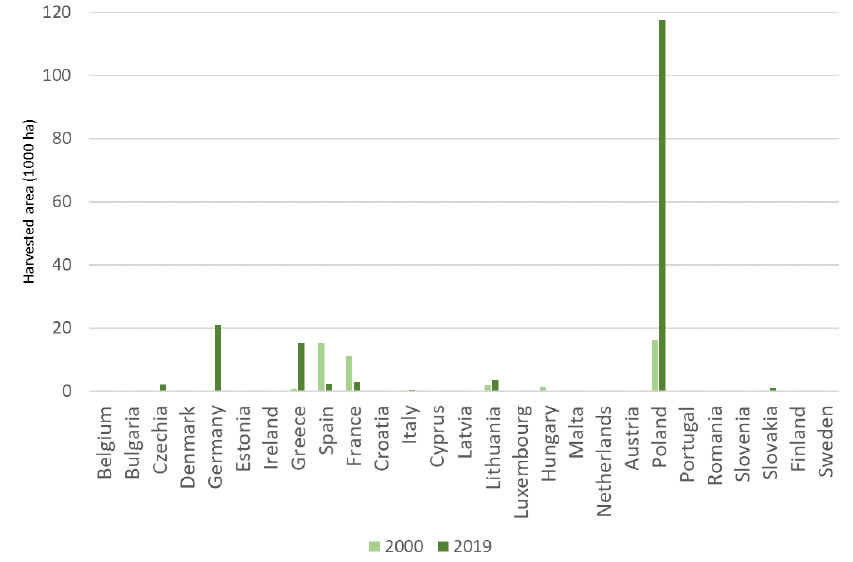
Figure 13. Harvested area of sweet lupin in EU countries in 2000 and 2019 [46].